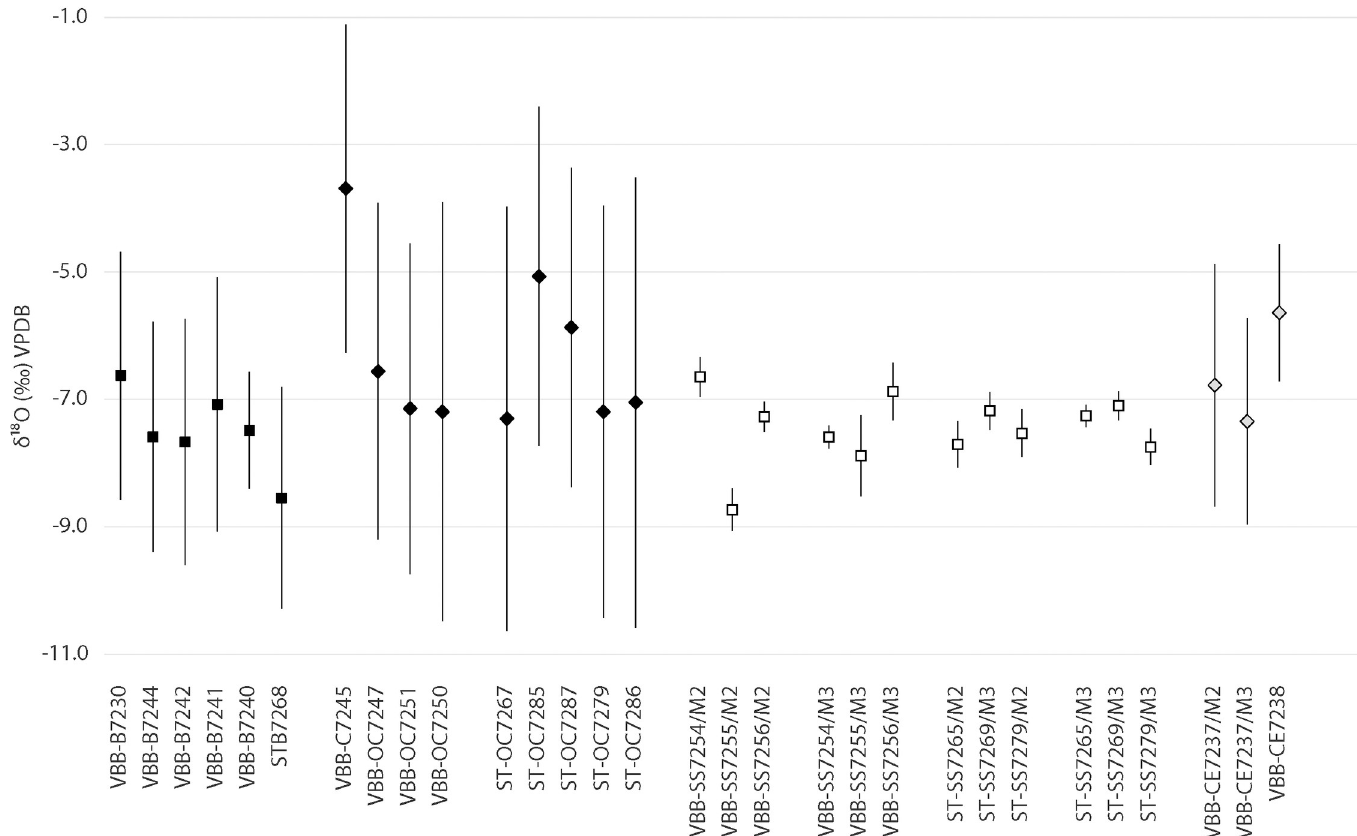
Fig 5. Comparison of δ 18 O ave , δ 18 O max and δ 18 O min for incremental samples. Cattle (B), pigs (SS), sheep/goat (OC) and red deer (CE) teeth from Vin č a-Belo brdo (VBB) and Stubline (ST).